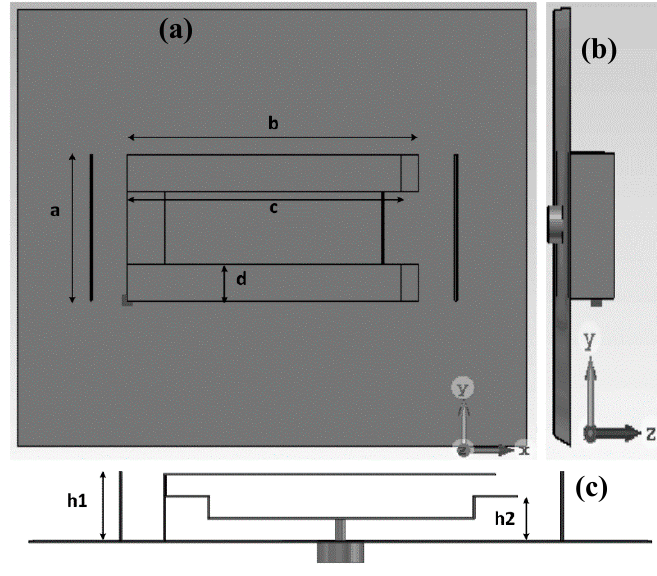
Figure 1. ( a ) Top; ( b ) side and ( c ) front views of the antenna.